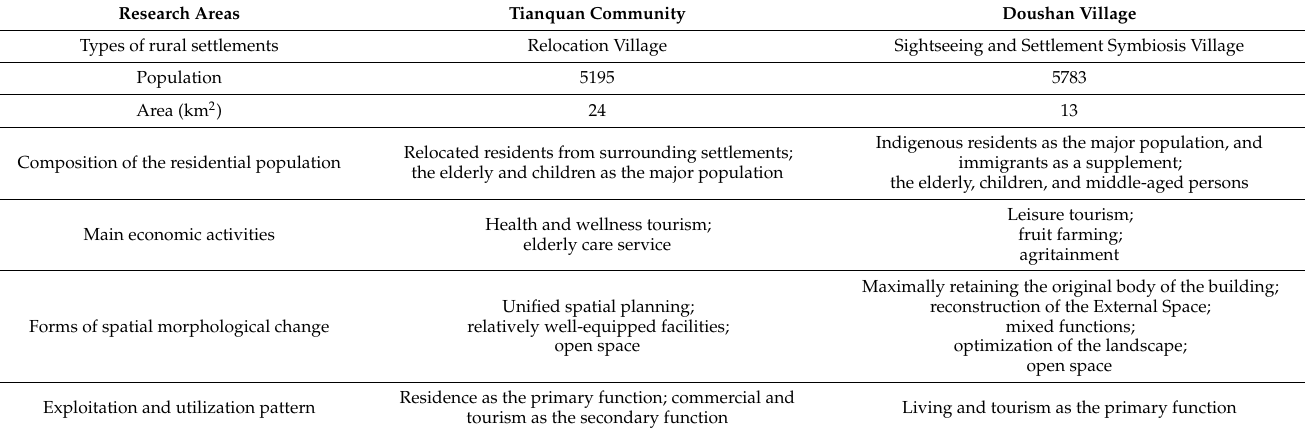
Table 2. Comparison between Tianquan Community and Doushan